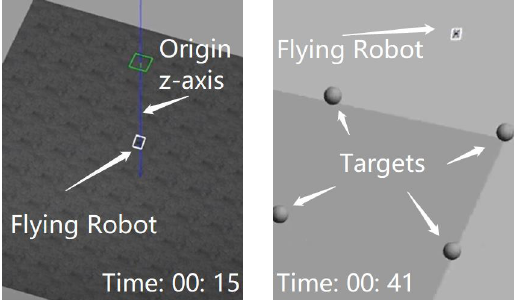
Figure 11. The time counting of cruising simulation, starting at 00:15 and reaching target area at 00:41. video available at: https://www.youtube.com/watch?v=39kbNOl3qs0 (accessed on 11 September 2022).